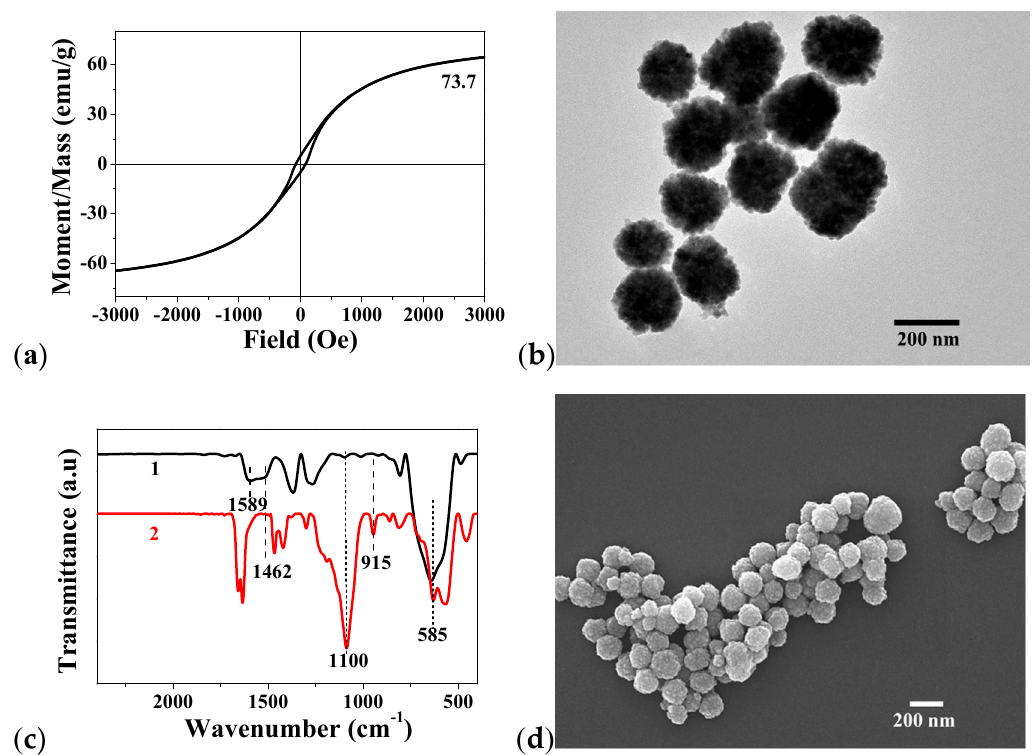
Figure 1. ( a ) VSM curve of the Fe 3 O 4 NP; ( b ) TEM image of Fe 3 O 4 NP; ( c ) Fourier transform infrared (FT-IR) spectra of Fe 3 O 4 NP (1) and Fe 3 O 4 @epoxide NP (2); ( d ) SEM image of Fe 3 O 4 @epoxide NP.